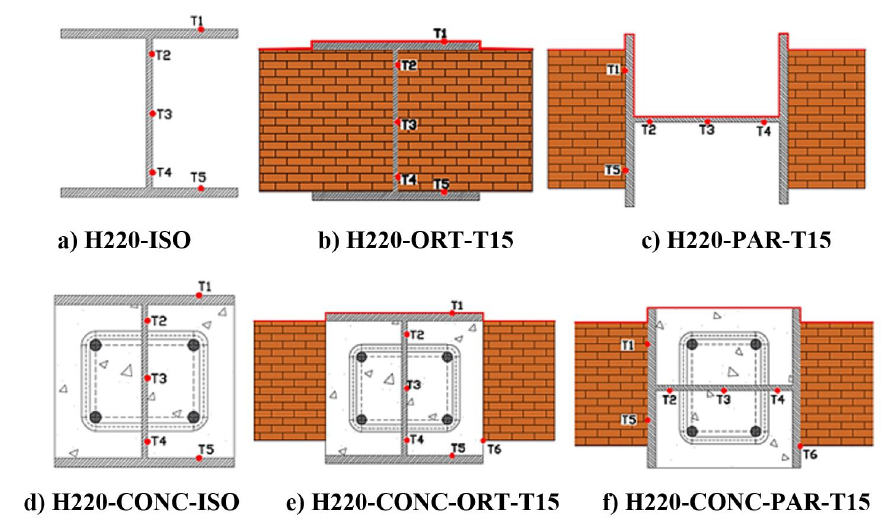
Figure 4. Positioning of thermocouples in the cross section of the columns under